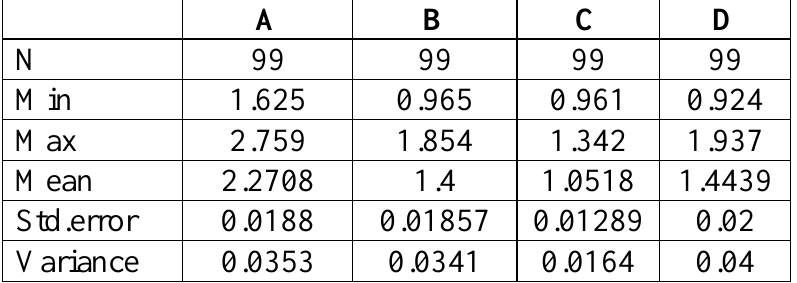
Table 2 : Univariate statistical results from four measured characters on M/1.